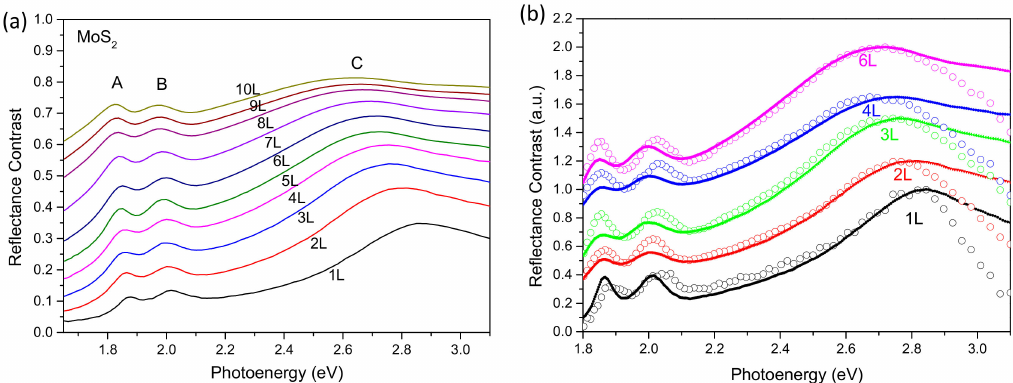
Figure 6. ( a ) Simulated reflectance contrast spectra of MoS 2 using Fresnel’s equations from monolayer to 10-layer. ( b ) Overlay of the measured spectra with the simulation. The open circles are the measured data. The solid lines are the simulations. The curves are shifted in the vertical axis for visual